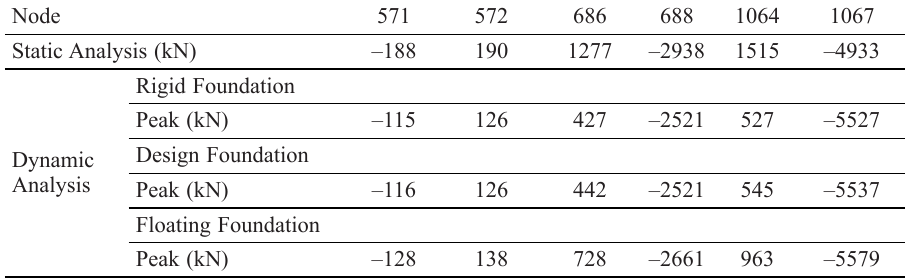
Table 8. Axial forces in some members of the tower GTS 01 due to TS wind